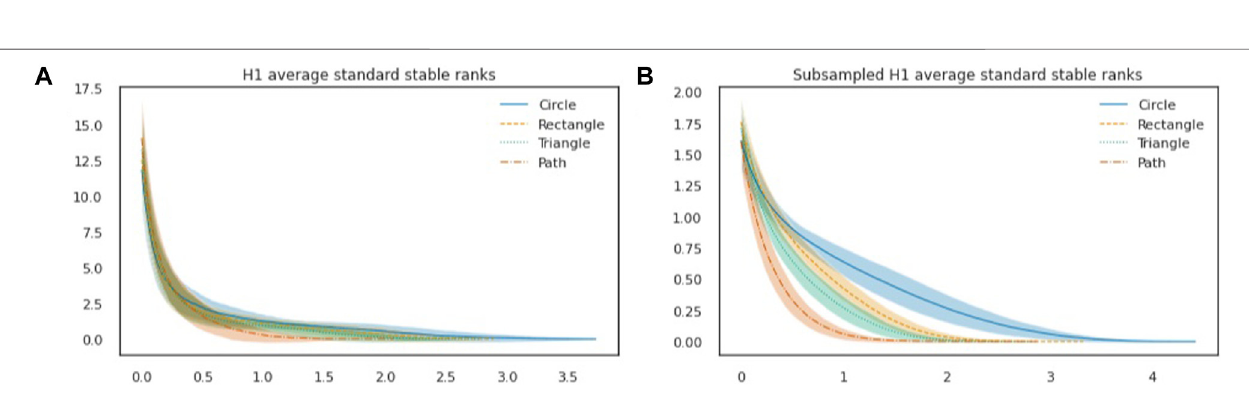
FIGURE8| Pointclouds generatedwithambient noise. (A) : 1-st homology averagestandardstable ranks (shaded area:standarddeviation). (B) :plane fi gures are represented by average 1-st homology standard stable ranks of subsamplings. Averages of these representations per shape are illustrated (shaded area: standard